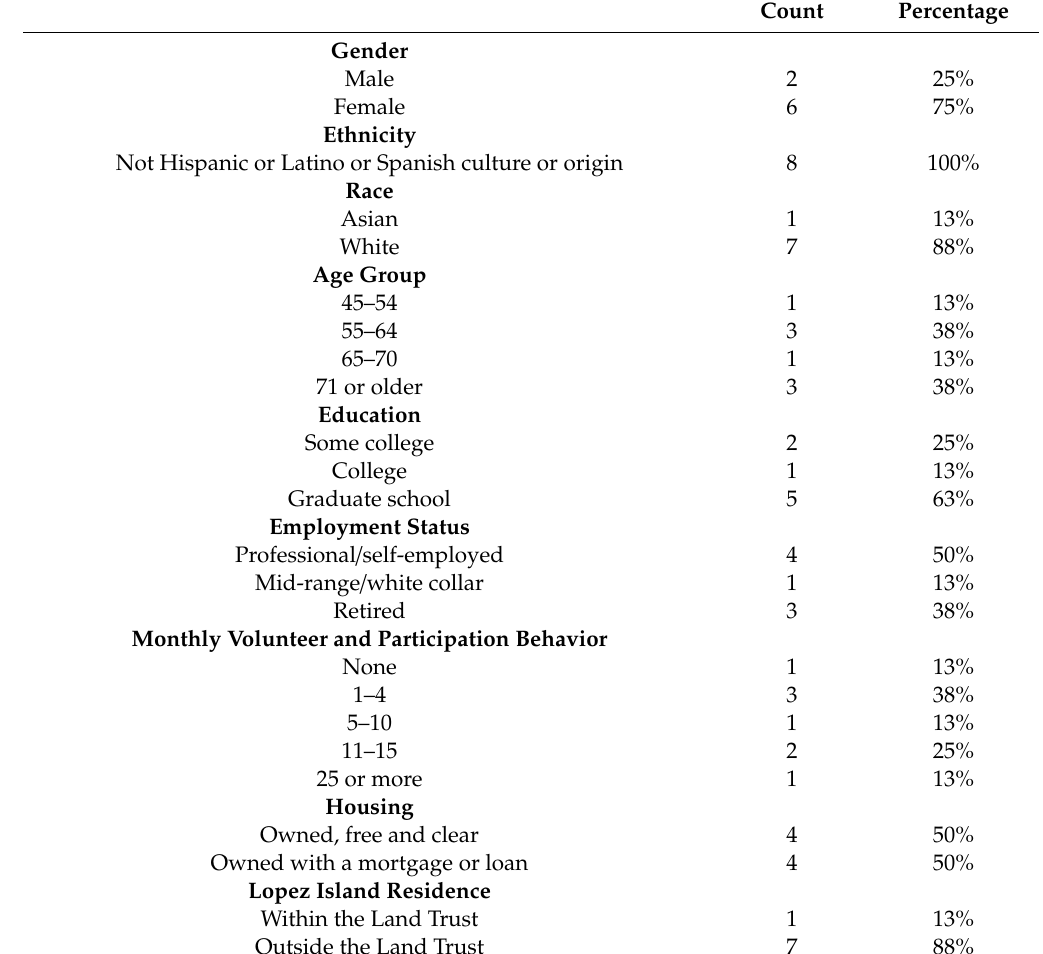
Table 2. Demographic characteristics of survey